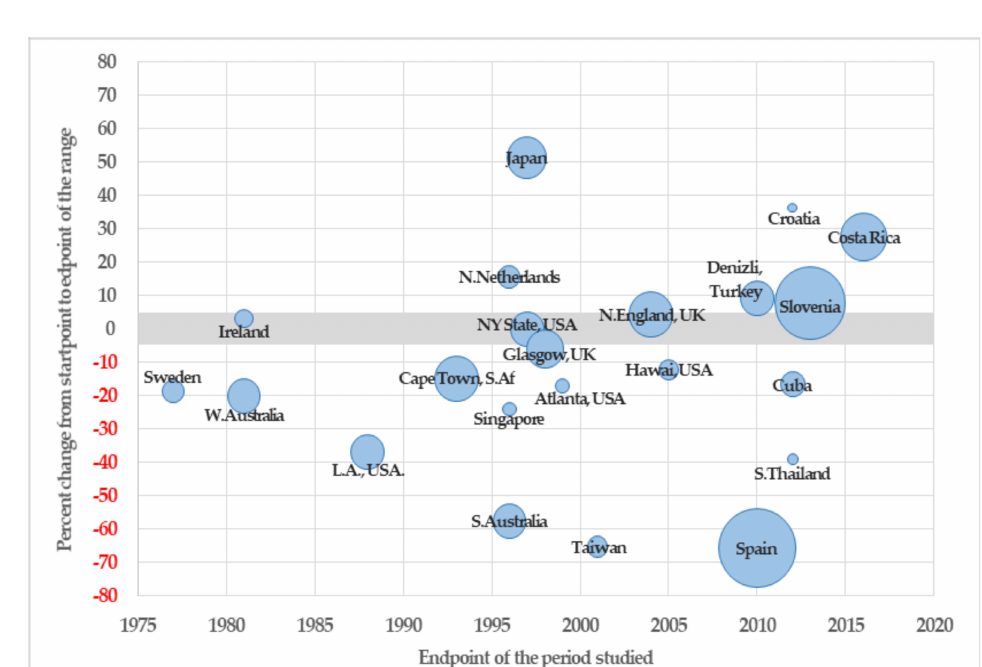
Figure 3. Selected studies by percent change in birthrate, region, endpoint, and time span of the period studied. Note: The area of the bubbles is proportional to the width of the period